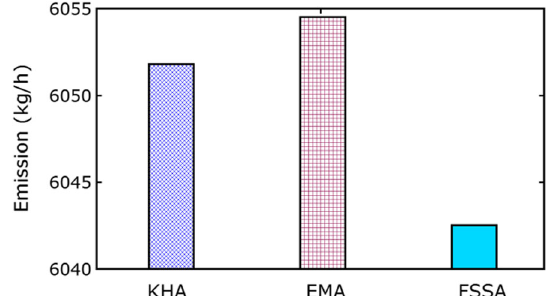
Fig. 4 Performance comparison of the FSSA approach with other techniques for emission objective